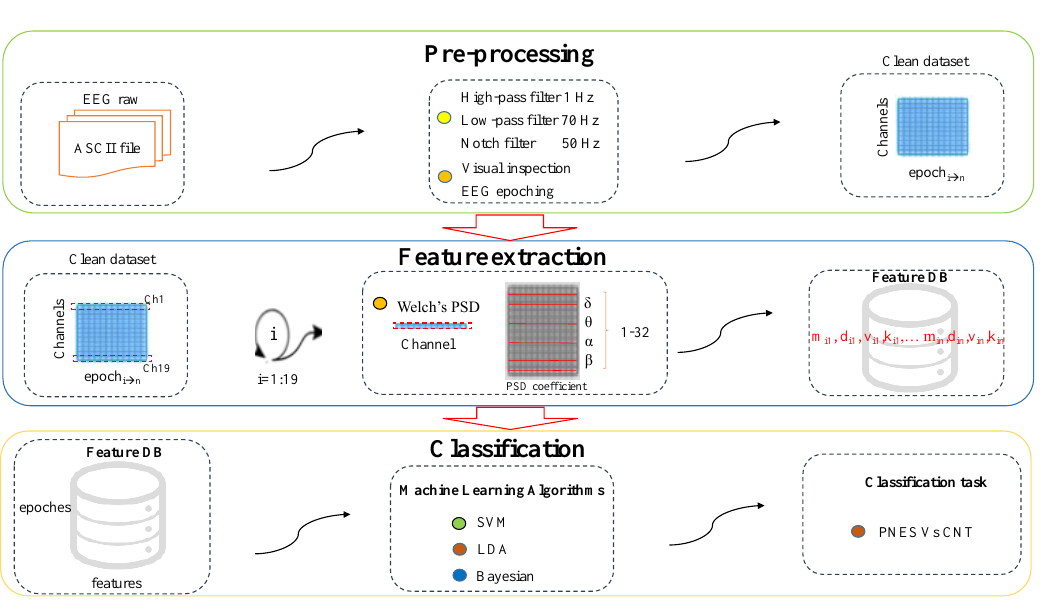
Figure 1. Software